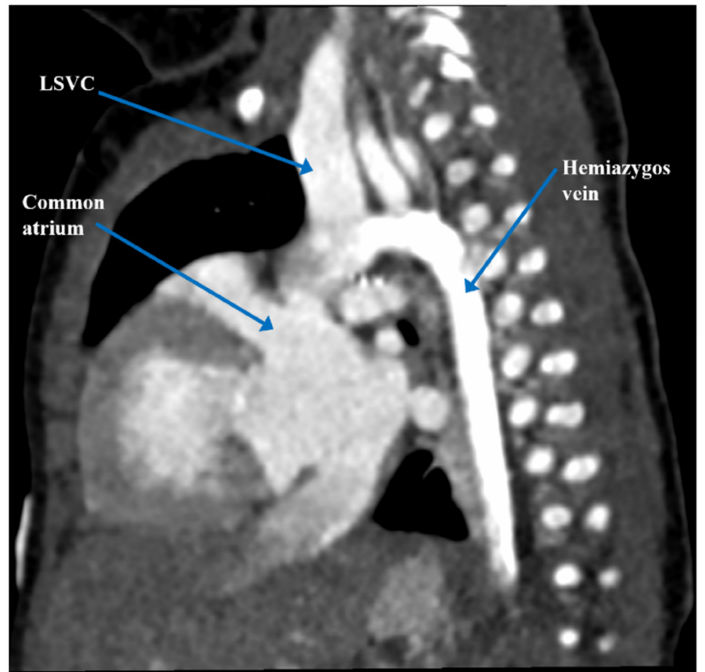
Figure 2. Pre-operative computerized tomography demonstrating hemiazygos vein draining into left SVC and subsequently into the left and anterior aspect of common atrium. LSVC = left superior vena cava.